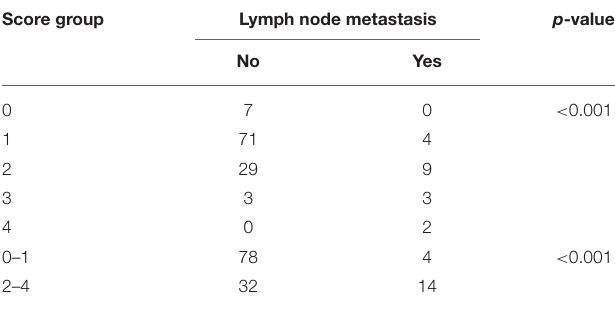
TABLE 7 | Correlation analysis between the score groups and presence of lymph nodes metastasis in the N + plus N0 with > 12 lymph nodes subgroup. Score group